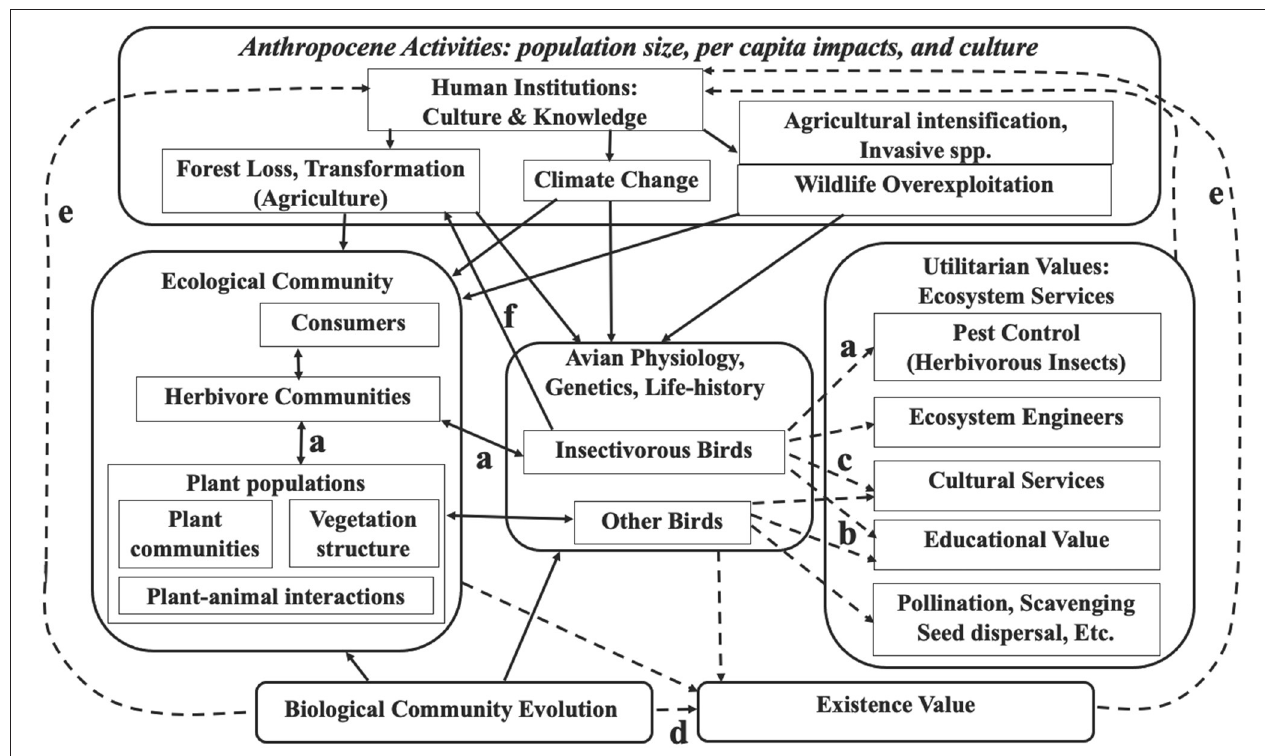
FIGURE 2 | Simplified mechanisms of threat to tropical insectivorous birds (from Figure 1 ) integrated with values of these animals and their ecosystems. Biological processes shown with solid arrow-headed lines; human values and concepts shown with dashed arrow-headed lines. As in Figure 1 , Anthropocene activities (upper box) all impact both species biodiversity components, the ecological community (left-middle box) and bird traits (central box). Several mechanisms or values are particularly important for tropical insectivorous birds. (a) By consuming herbivorous insects these birds potentially influence plant demography (a trophic cascade), and vice versa, hence the double-headed arrows. (b) Extraordinary tropical species richness and diverse ecological roles within communities underscore ecosystem utilitarian values of birds, including insectivorous species. (c) The diversity of tropical birds and the charismatic traits of many species, emphasize their potential cultural ecosystem value, e.g., for ecotourism and education. (d) The long evolutionary history, specializations, and life-histories of tropical birds emphasize their intrinsic value, and thus indirectly their potential to educate humans. (e) Knowledge of the evolutionary history and traits of tropical insectivorous birds can feedback into human knowledge, culture, and ultimately conservation action, and thus help humans change how we relate to nature. (f) Related to mechanism (a), insectivorous birds benefit humans directly, economically by controlling agricultural crop